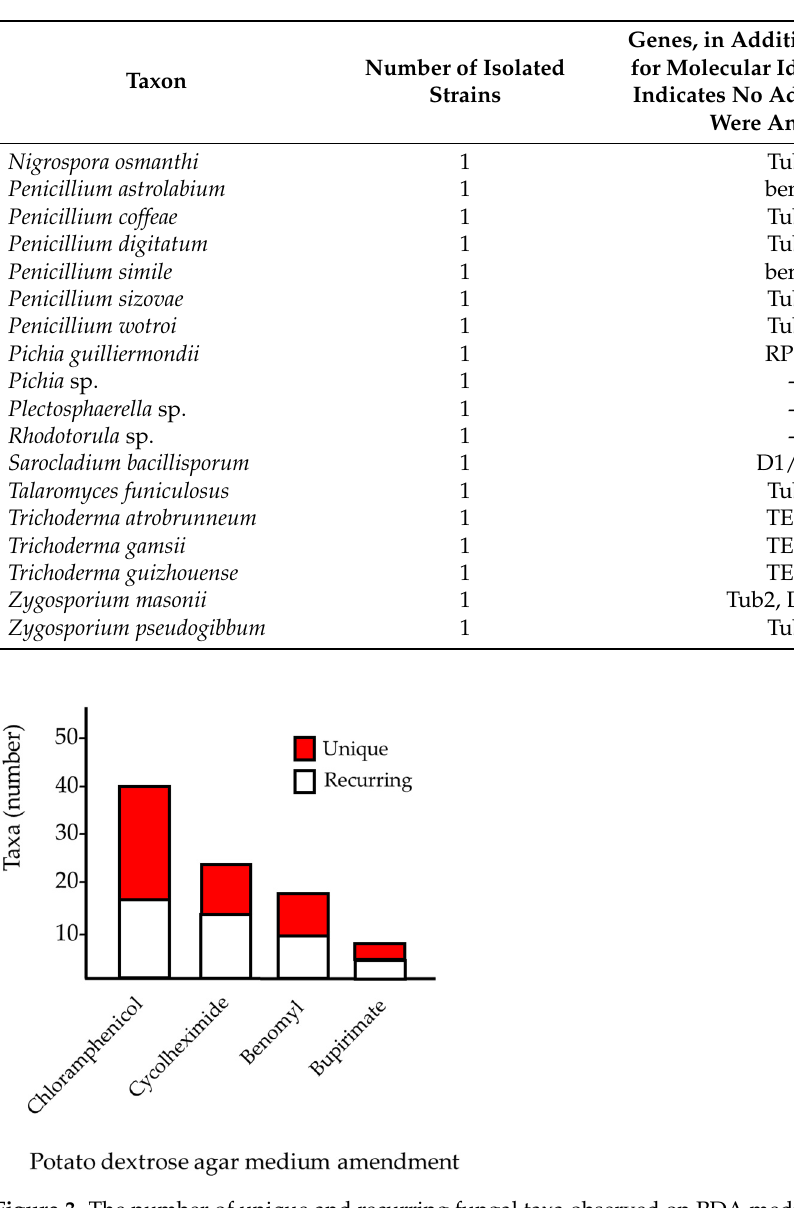
Figure 3. The number of unique and recurring fungal taxa observed on PDA medium with differ- ent